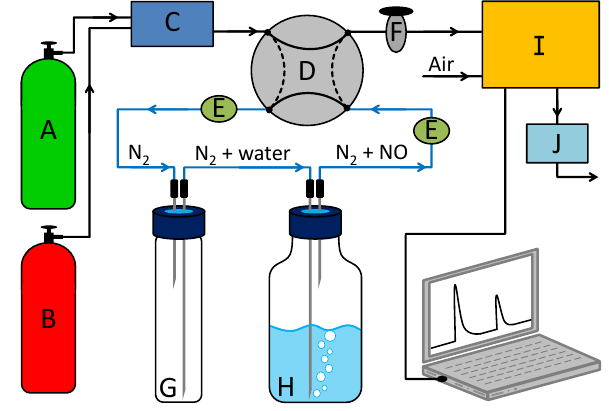
Figure 1. Schematic set-up of the developed measurement system consisting of an NO analyser connected to a stripping unit (blue lines). A: N 2 gas cylinder; B: reference gas cylinder; C: mass flow controller; D: four-way valve (solid lines: mode A; dashed lines: mode B); E: inline filter; F: needle valve; G: sample vial; H: strip- ping vial filled with water; I: NO analyser with air supply for ozone generator; J: vacuum pump with vent.